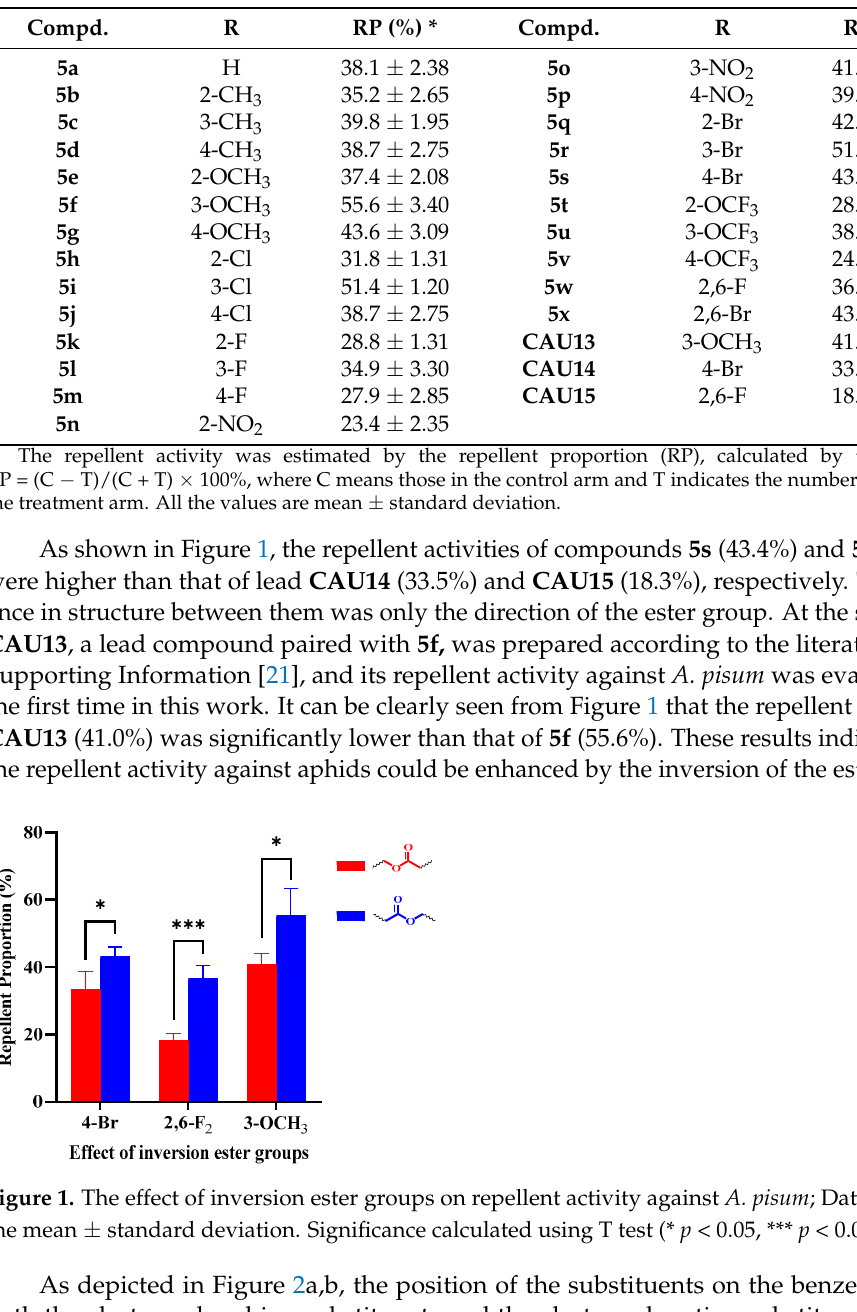
Table 1. Repellent activity of compounds 5a–5x .